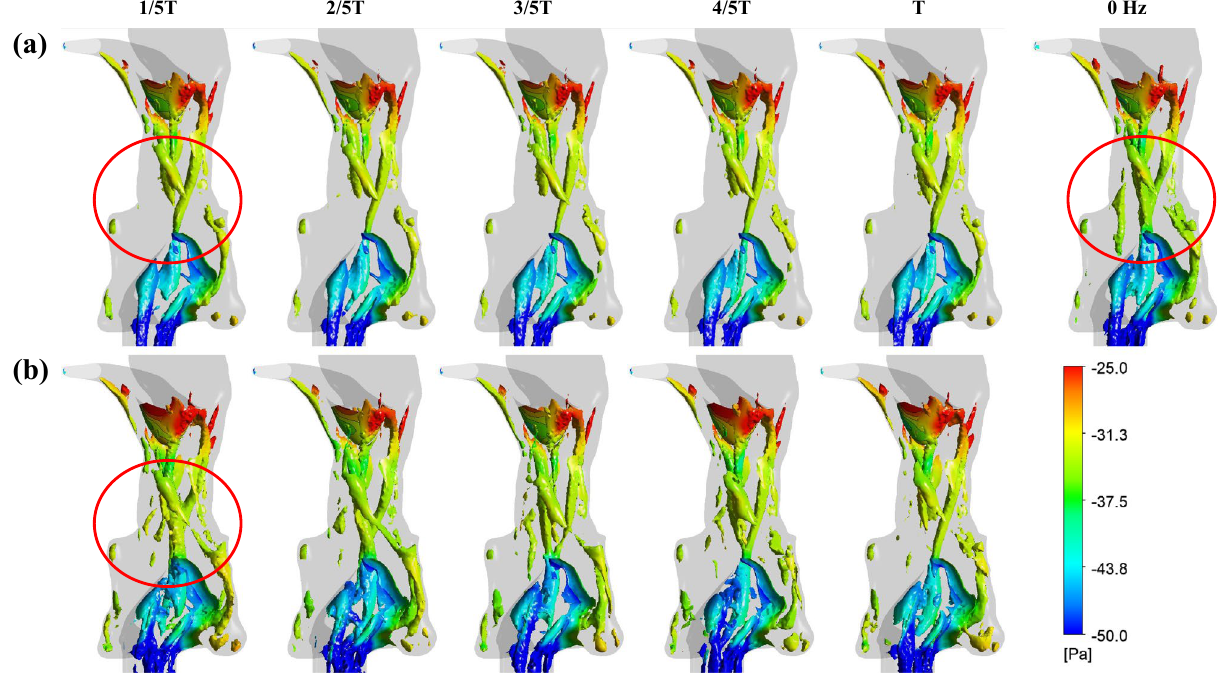
Figure 1. Comparison of airway vortex structures within a uvula flapping period (T) under all flapping frequencies, including 0 Hz (stationary airway), ( a ) 20 Hz, and ( b ) 40 Hz. Three-dimensional wake topologies are visualized using the Liutex-criteria (vortex absolute strength = 500). The iso-surfaces are colored by local pressure and displacement responses to the uvula flapping are found concerning energy distribution and fre- quency. At ω